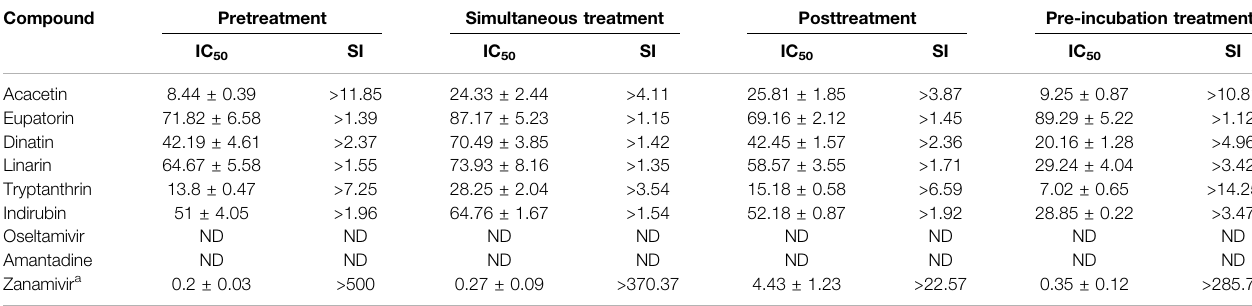
TABLE 4 | Cytopathic effect (CPE) reduction assay results of the six predicted compounds toward the oseltamivir- and amantadine-resistant H1N1.